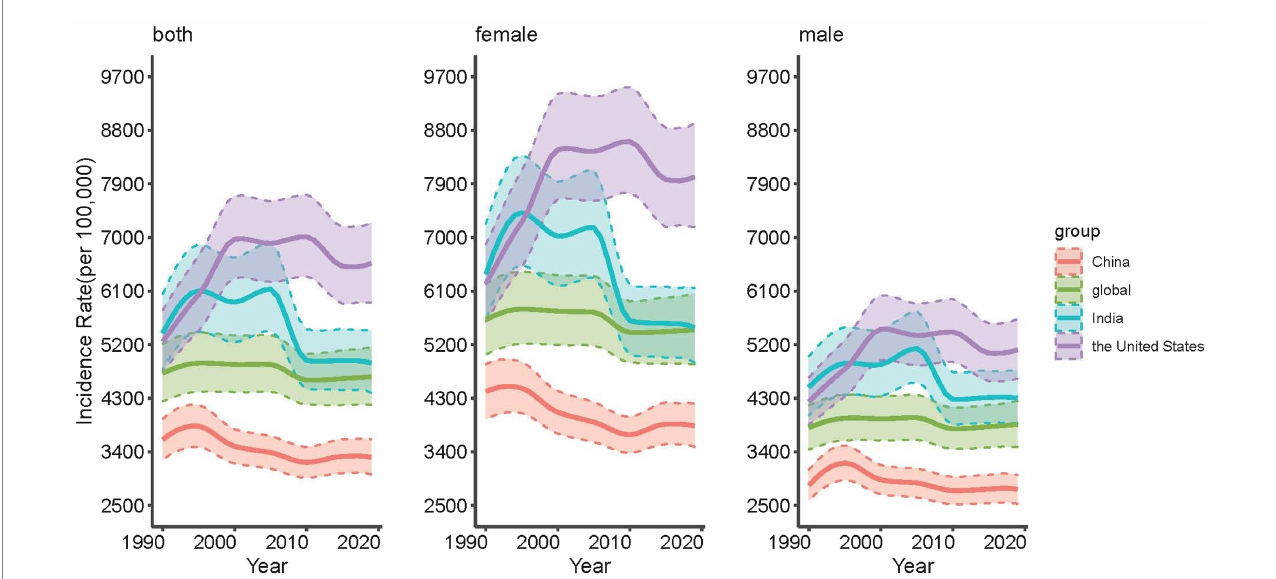
FIGURE 1 Trends of age-standardized incidence rates (ASIR) for mental disorders in the whole population, males and females in China, the United States, India and the global, 1990 to 2019.